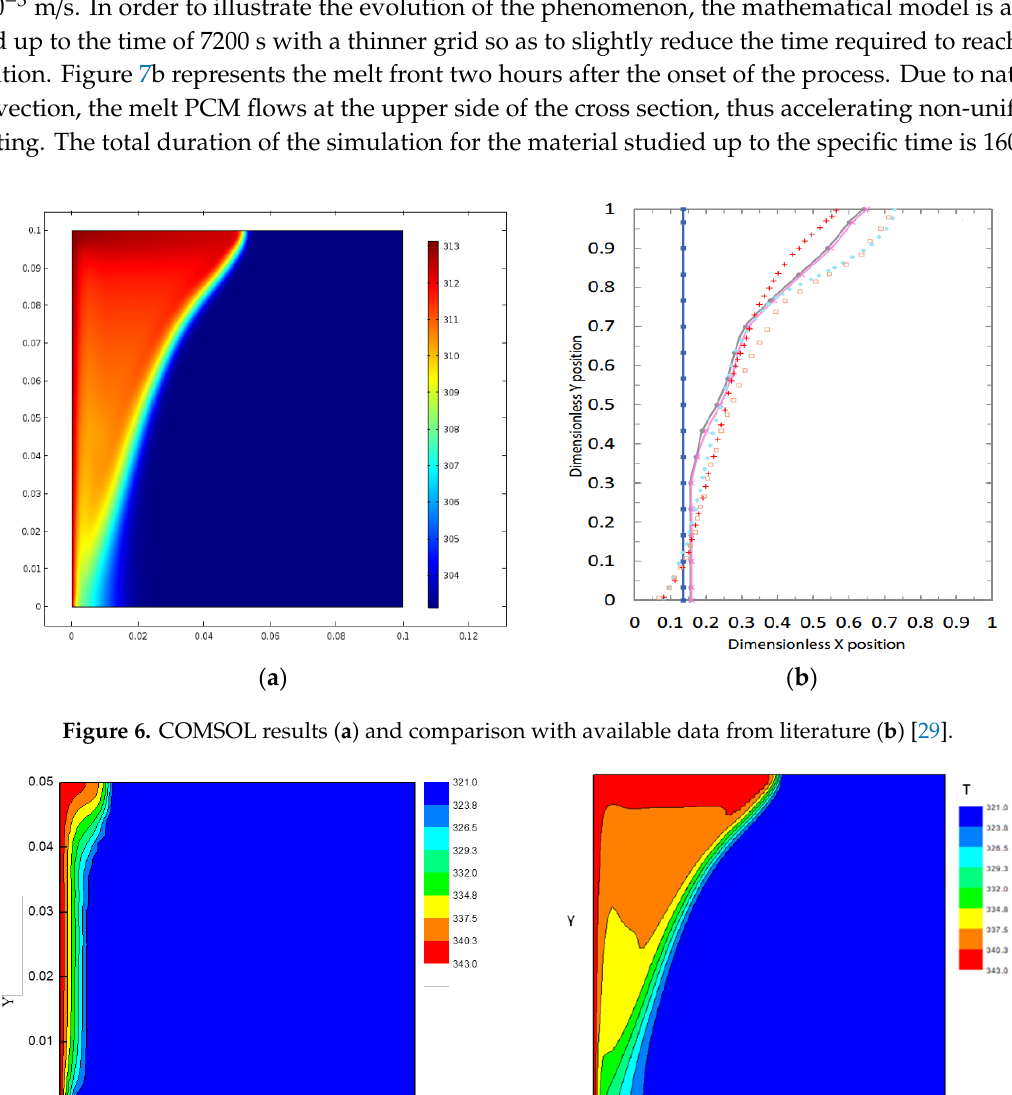
Figure 7. Melting front of RT50, ( a ) for the first 250 s and ( b ) at t = 7200 s.